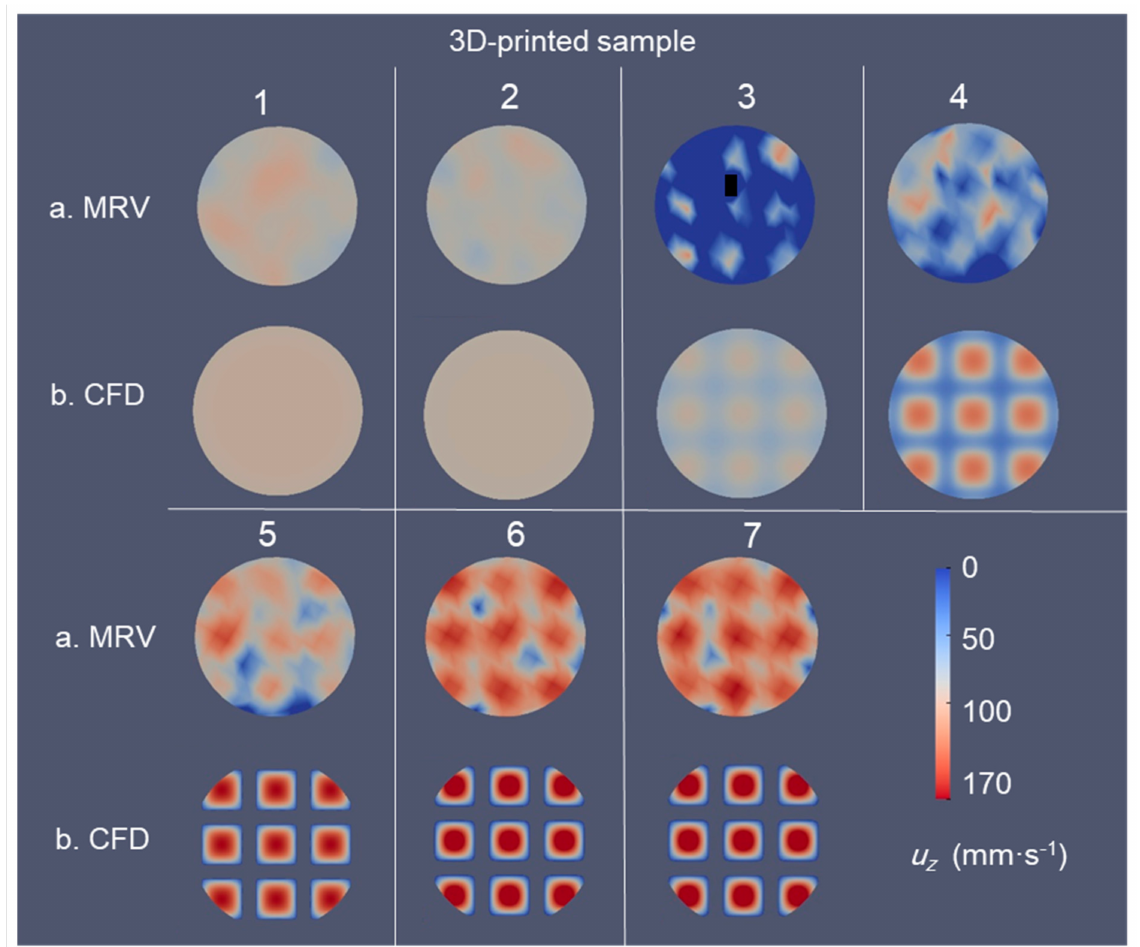
Figure 12. Axial velocity distribution along the entrance region within ROI(1) determined by MRV. The slice numbers correspond to the illustrated markers at the entrance region in Figure 9a. The two mentioned pixels at slice 3 with a negative value of u z are shown by black